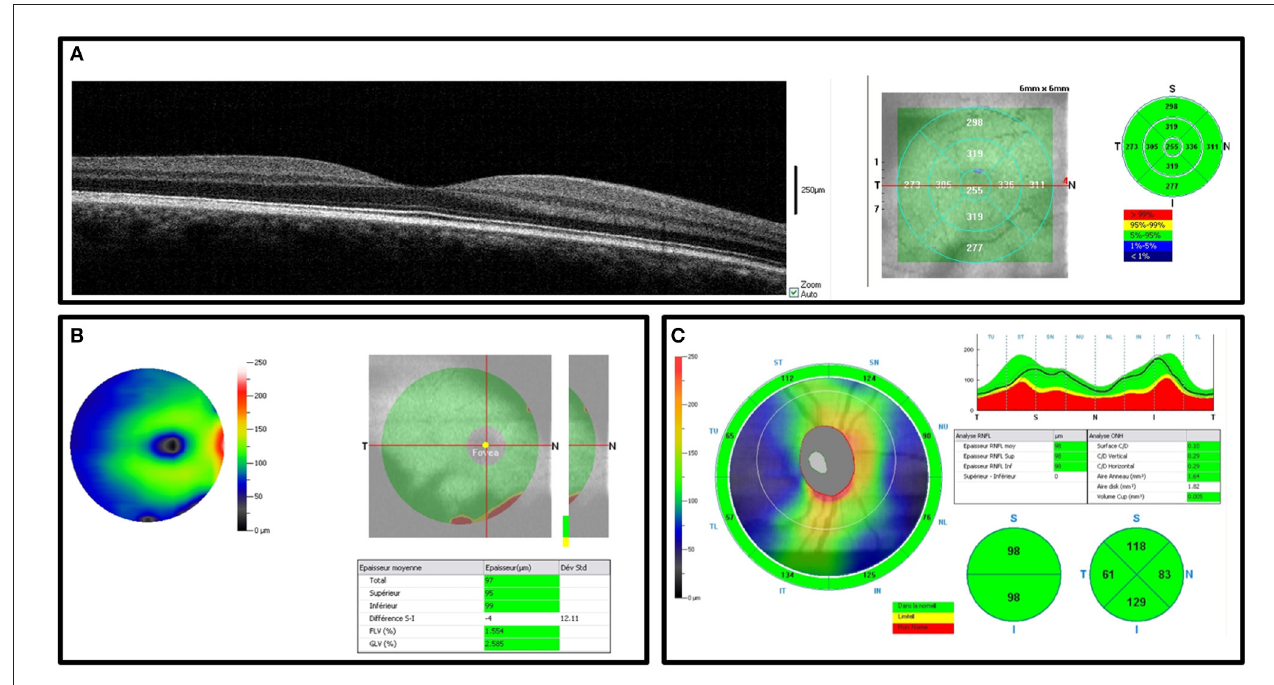
FIGURE 4 | Spectral-domain OCT showing the right eye in one subject before DI. (A) Macular thickness. (B) Ganglion cell complex (GCC) and significance maps. (C) Optic nerve head (ONH) and retinal nerve fiber thickness.